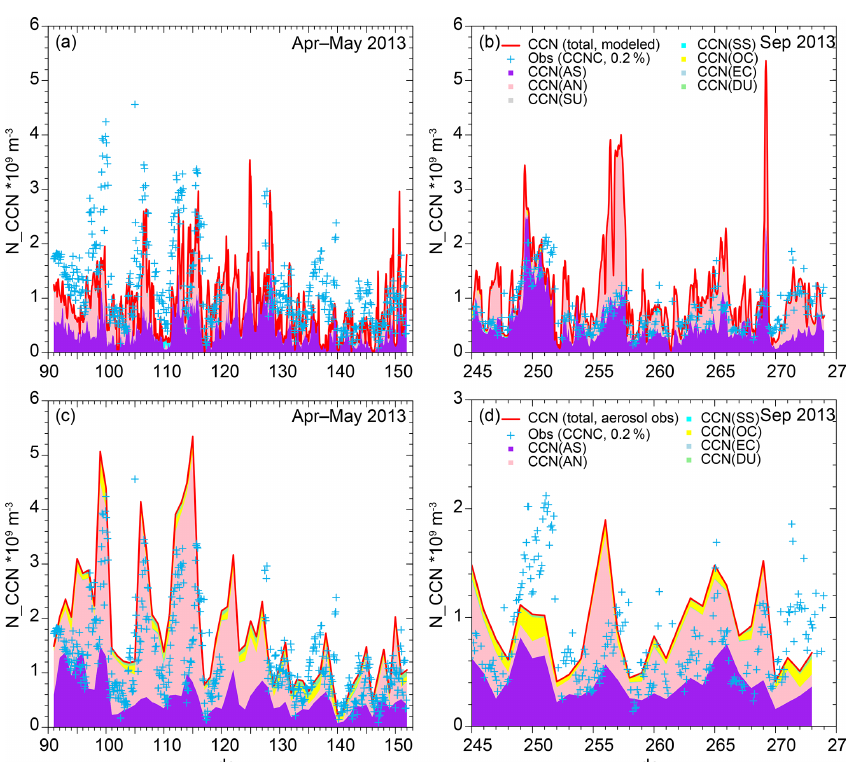
Figure 2. Simulated and measured CCN number concentrations in Melpitz at a supersaturation of 0.2% during the two HOPE campaigns (April to May and September 2013). Panels (a) and (b) show the CCN number concentrations resulting from the simulated aerosol concentra- tions, while panels (c) and (d) show the CCN numbers resulting from measured aerosol concentrations using the same CCN parametrization. The colors represent the contributions to CCN of different species. The blue crosses indicate the CCN number concentrations using the CCNC. Please note the different time resolution for the observations and the different scale for the CCN number concentration in (d)